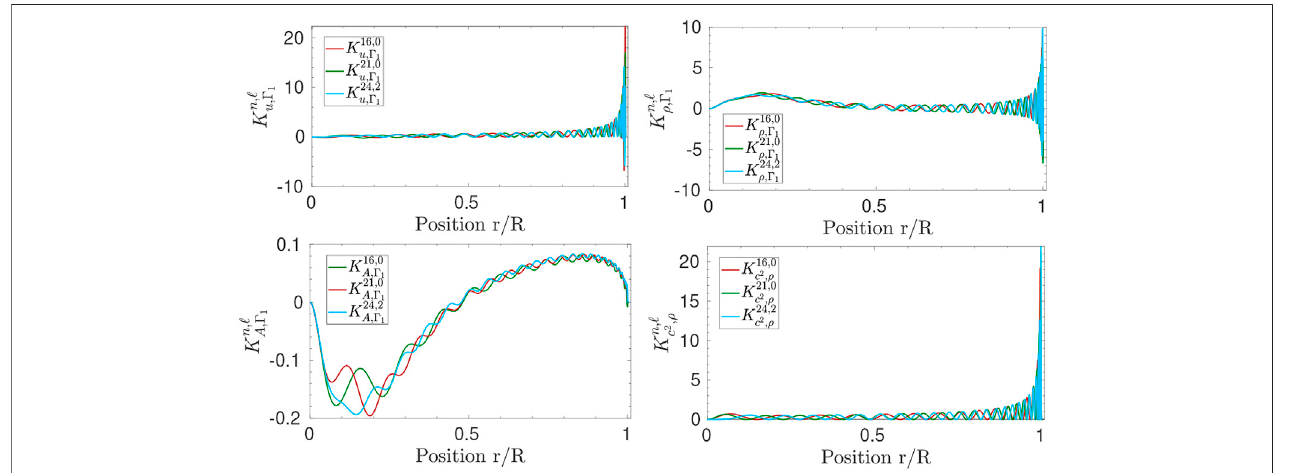
FIGURE 3 | Structural kernels for various structural pairs and for low degree oscillations modes for a representative model of 16CygA from Buldgen et al. (2022). Each panel illustrates a different variable that can be used for variational inversions of the structure of a star as well as the degeneracy in the shape of the kernels for low degree